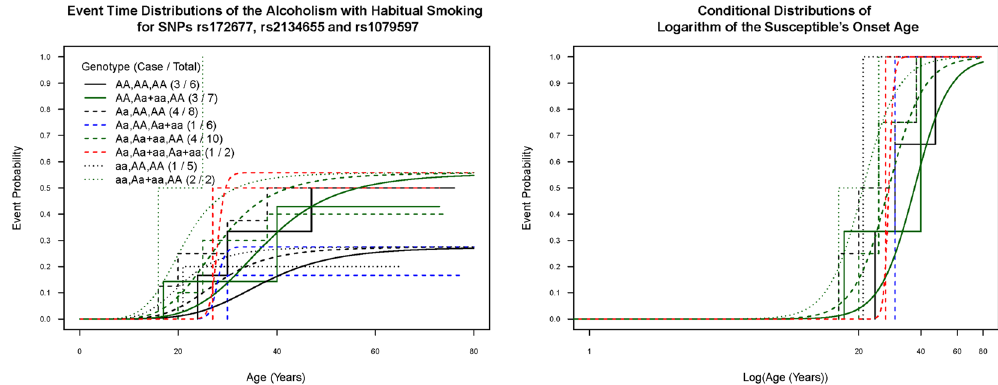
Figure 3. Kaplan–Meier (step function) and multiple mixture regression (smooth curve) estimators of overall and conditional event curves in all habitual smokers for the alcoholism onset age by genotypes of three SNPs and habitual smoking.